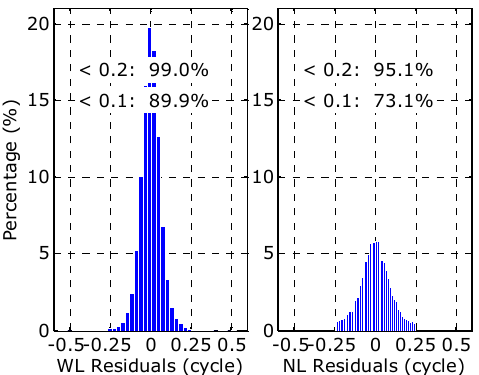
Figure 12. Distribution of a posteriori residuals of WL and NL float ambiguities in GLONASS WL IFCB calibration. Receivers with heterogeneous types are used rover sites.